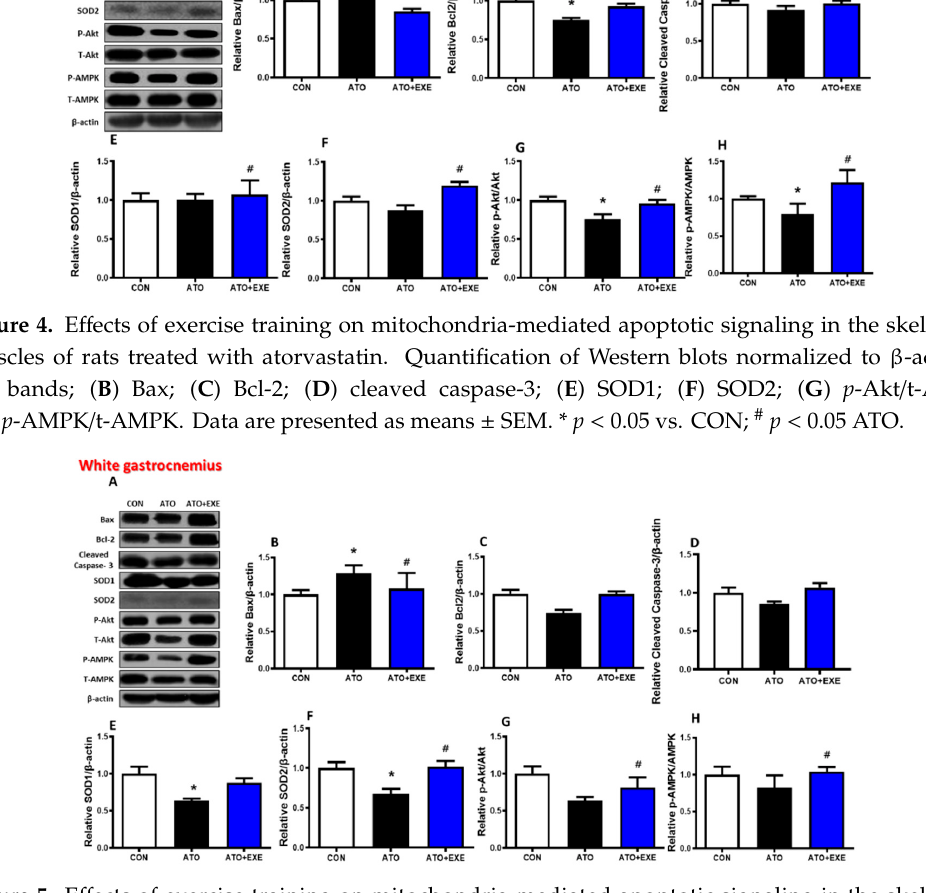
Figure 5. E ff ects of exercise training on mitochondria-mediated apoptotic signaling in the skeletal muscles of rats treated with atorvastatin. Quantification of Western blots normalized to β -actin. ( A ) bands; ( B ) Bax; ( C ) Bcl-2; ( D ) cleaved caspase-3; ( E ) SOD1; ( F ) SOD2; ( G ) p -Akt / t-Akt; ( H ) p -AMPK / t-AMPK. Data are presented as means ± SEM. * p < 0.05 vs. CON; # p < 0.05 ATO.